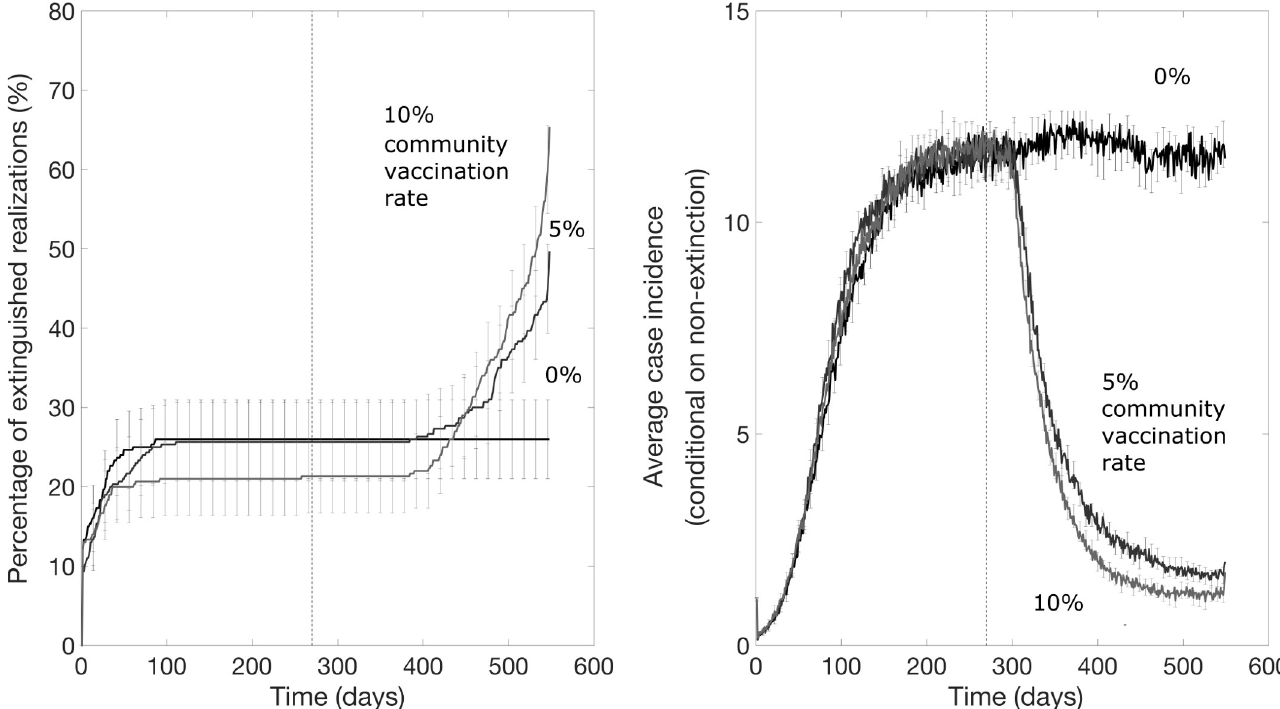
Fig 9. Probability of epidemic extinction over time and the mean daily case incidence when different community vaccination rates supplement a ring vaccination strategy for a 30% level of household inaccessibility and community vaccination starts 9 months after epidemic onset. The vertical dashed line indicates the timing of start of community vaccination. These simulations were generated using the exponential transmission profile, but similar results were obtained using the gravity transmission profile described in the main text. https://doi.org/10.1371/journal.pntd.0007814.g009 PLOS NeglectedTropical Diseases | https://doi.org/10.1371/journal.pntd.0007814 November21,